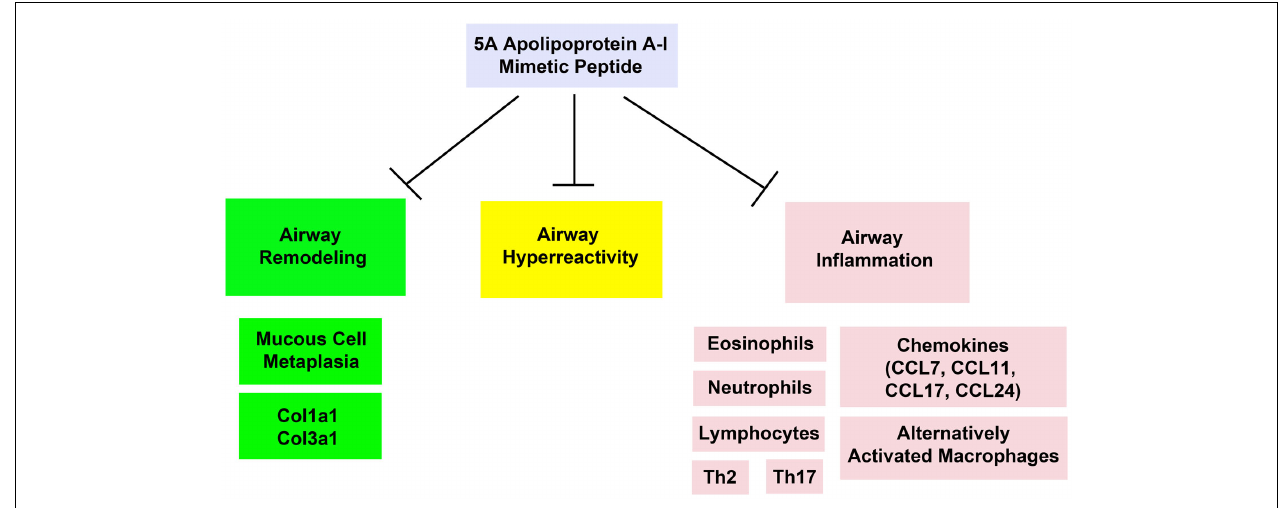
FIGURE 4 | Exogenous administration of the 5A apolipoproteinA-I mimetic peptide attenuates the induction of airway remodeling, airway hyperreactivity, and airway inflammation in a murine model of house dust mite-induced asthma (Yao et al.,